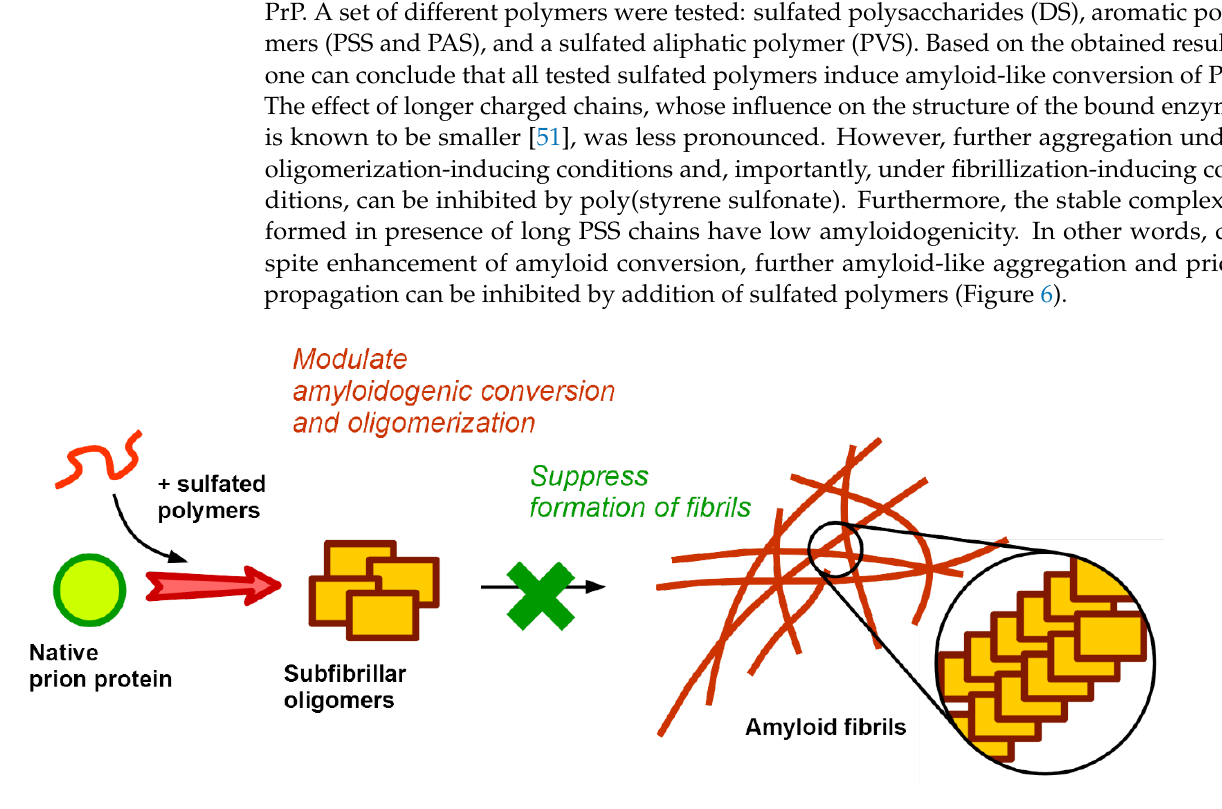
Figure 6. The scheme of the anti-amyloid action of sulfated polymers.